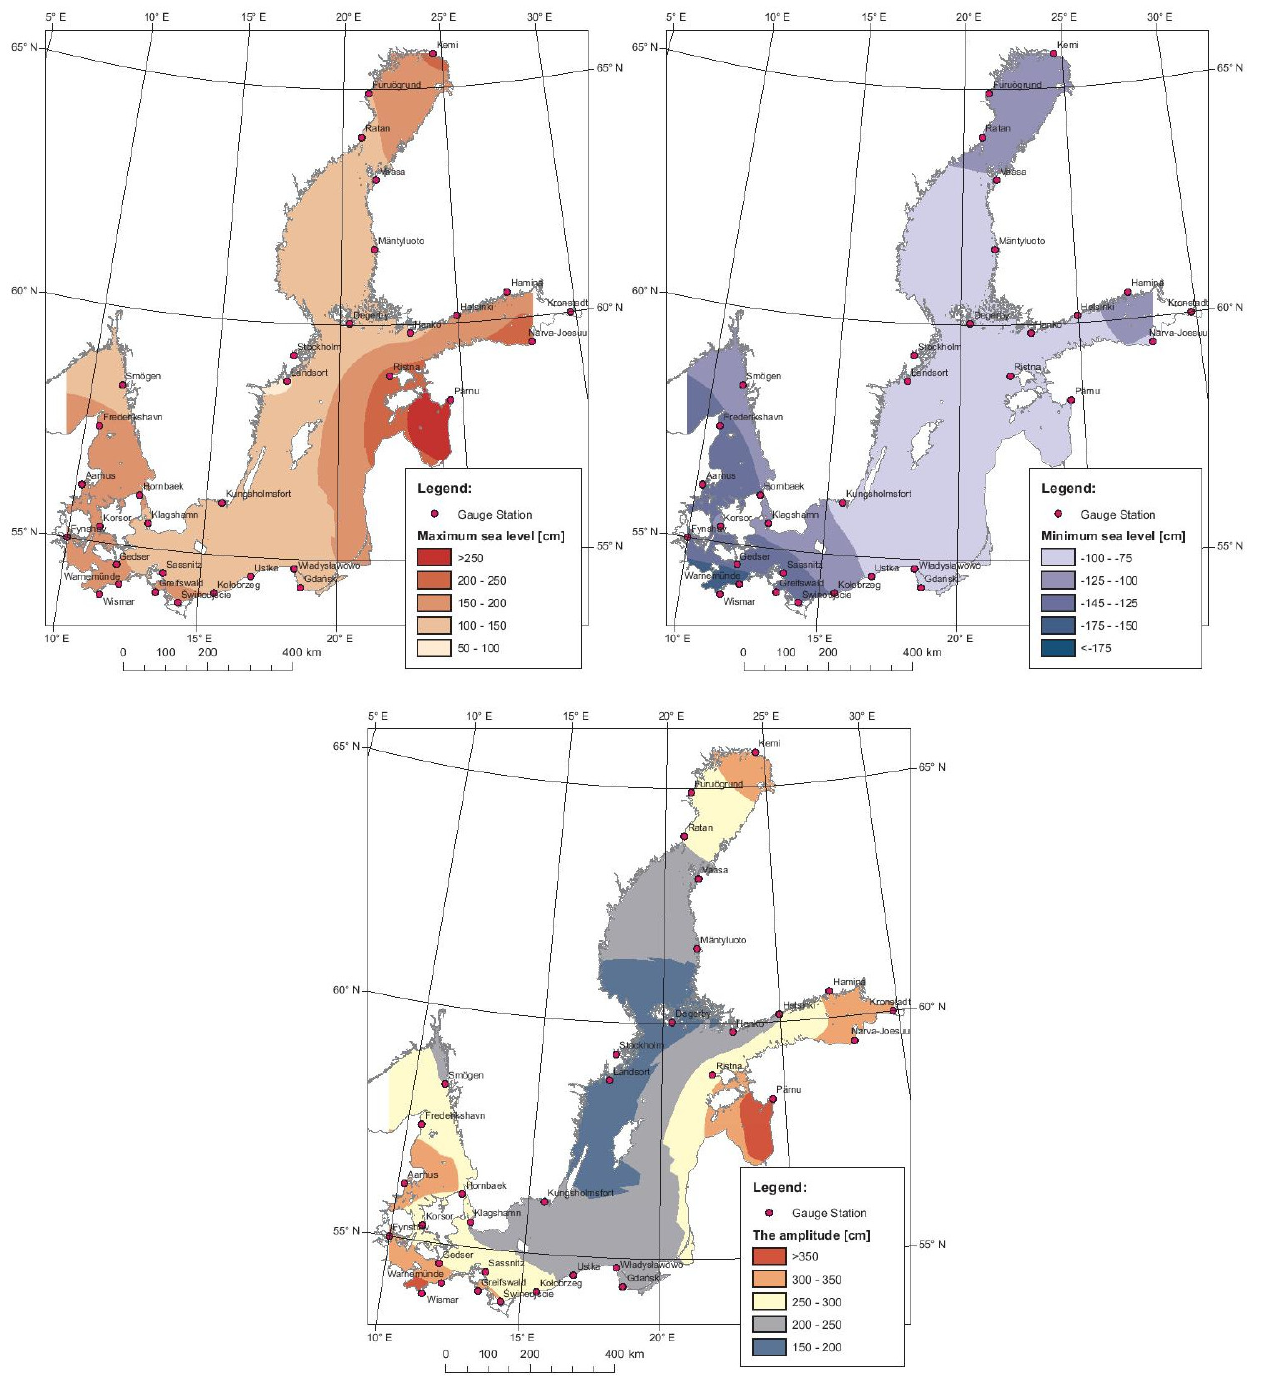
Figure 4. Surface water topography of the Baltic Sea for maximum levels (a) , minimum levels (b) , and the amplitude of variations (c) from the 1960–2010 period (Wolski et al.,